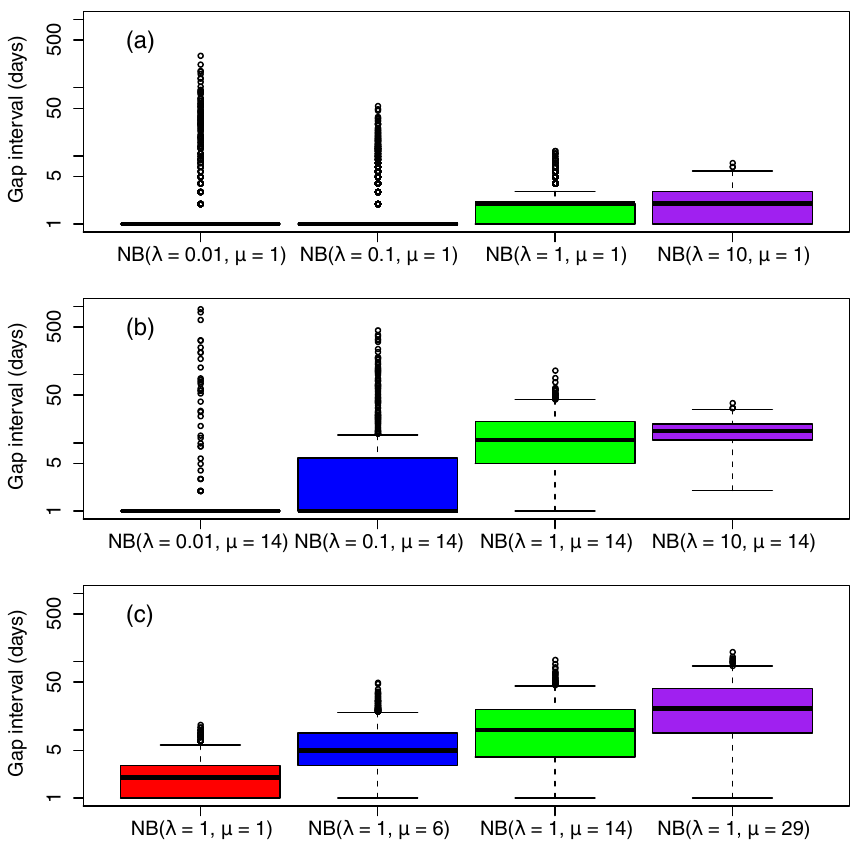
Figure 2. Examples of gap-interval simulation using negative binomial distributions, NB (shape λ , mean µ ). Simulation parame- ters: L = 9125 days, (cid:49)t nominal = 1 day. The three panels show simulation with fixed (a) µ = 1, (b) µ = 14, and (c) λ = 1. Note that (cid:49)t average / (cid:49)t nominal = µ + 1.